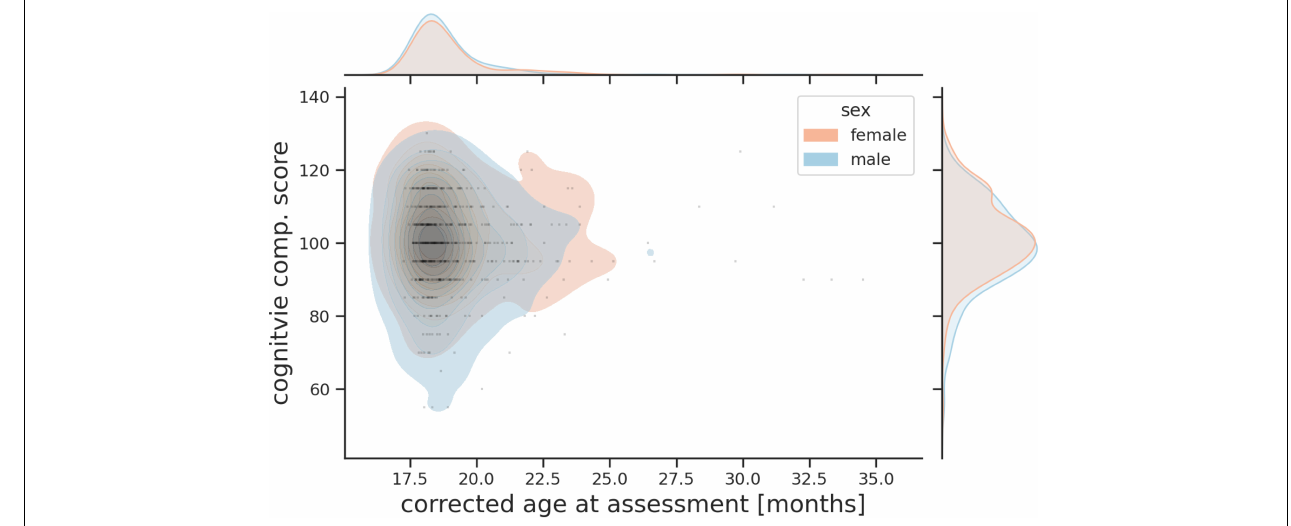
FIGURE 9 | Probability plot showing age of assessment and combined Bayley III cognitive score for boys and girls.